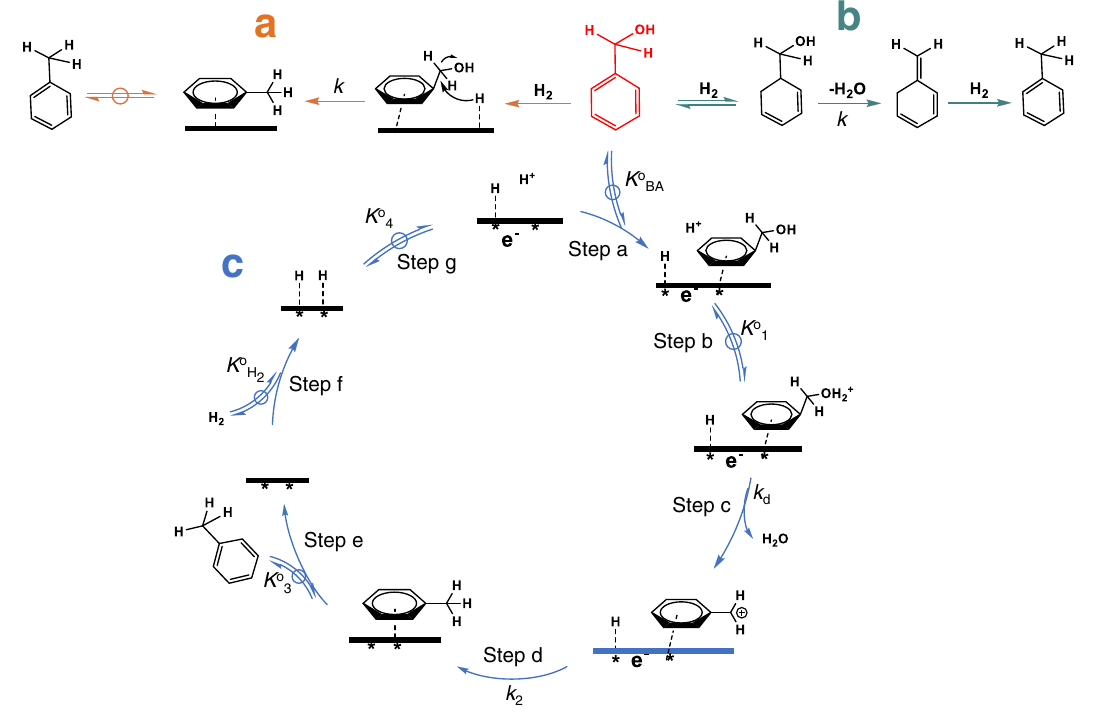
Fig. 4 | Reaction pathway of benzyl alcohol hydrogenolysis. a Direct hydrogenolysis, b partial hydrogenation – dehydration – re-hydrogenation and c protonation – dehydration – hydride addition (Fig. 4 c ). Elementary steps in Fig. 4 a , b are omitted and the hydronium ion is expressed as proton in the scheme.